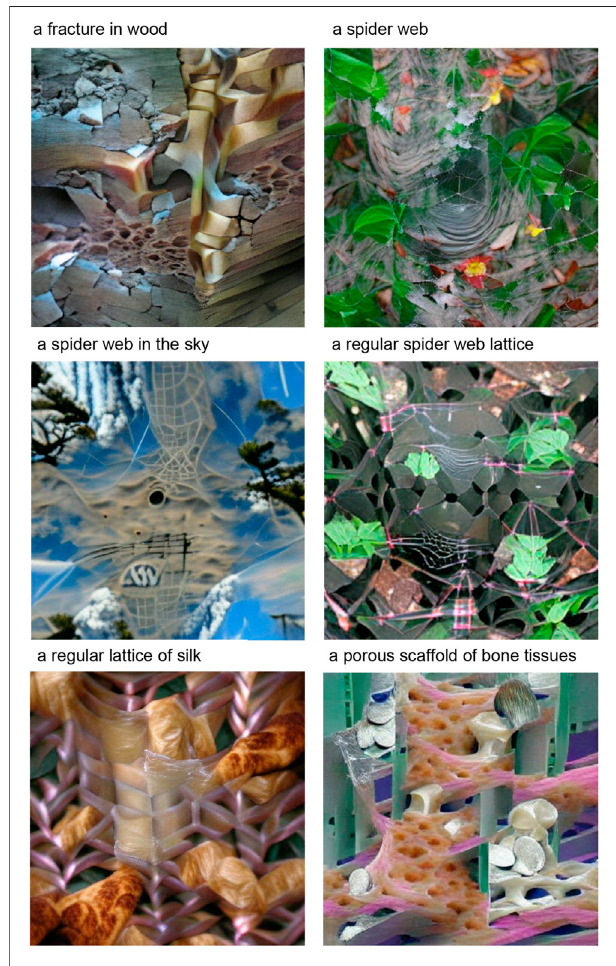
FIGURE 3 | Example images generated from various text input. As the examples show, interesting material designs can result, which can be further analyzed and